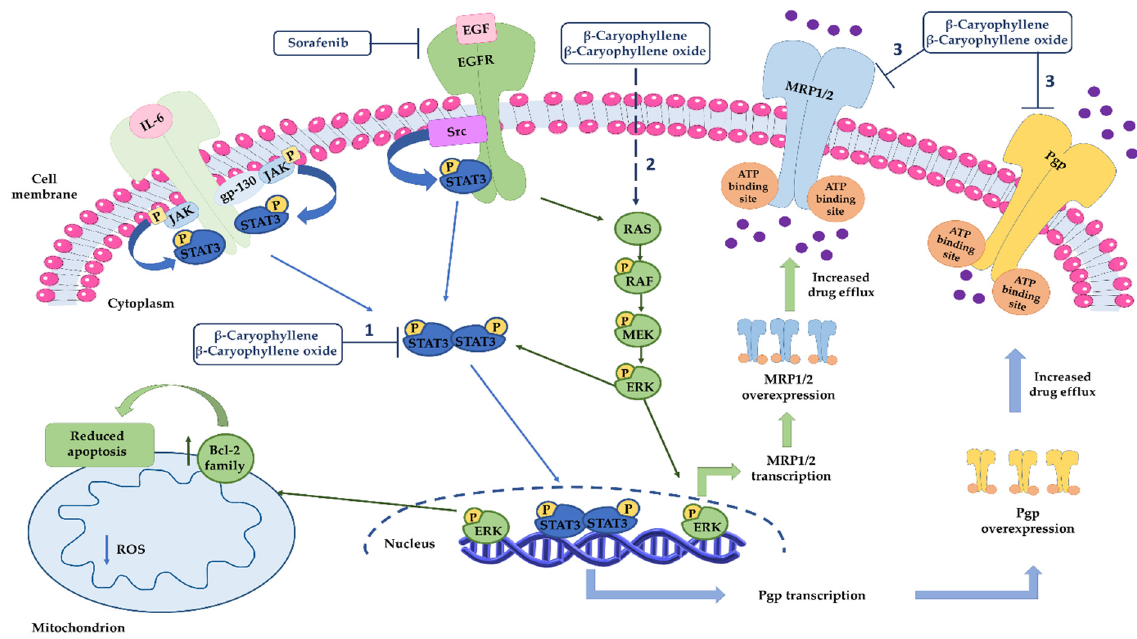
Figure 15. Mechanisms involved in sorafenib chemosensitization by caryophyllane sesquiterpenes. (1) β -Caryophyllene and β -caryophyllene oxide modulate Pgp expression through the inhibition of STAT3 signaling, which is involved in MDR1 gene overexpression in different cancer cells. (2) Caryophyllane sesquiterpenes can affect MRP1 and MRP2 expression likely by MAPK/ERK pathway, although the exact mechanism deserves further investigation. (3) β -Caryophyllene and β - caryophyllene oxide can directly inhibit Pgp and MRP1/2 pumps.